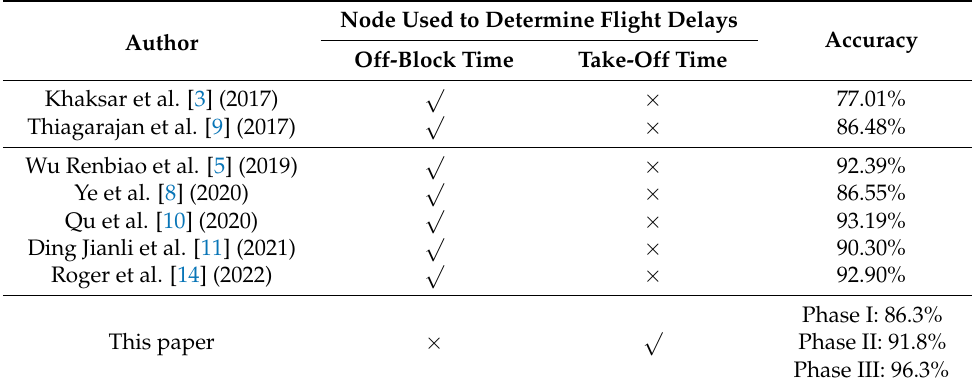
Table 13. Comparison between this paper and existing